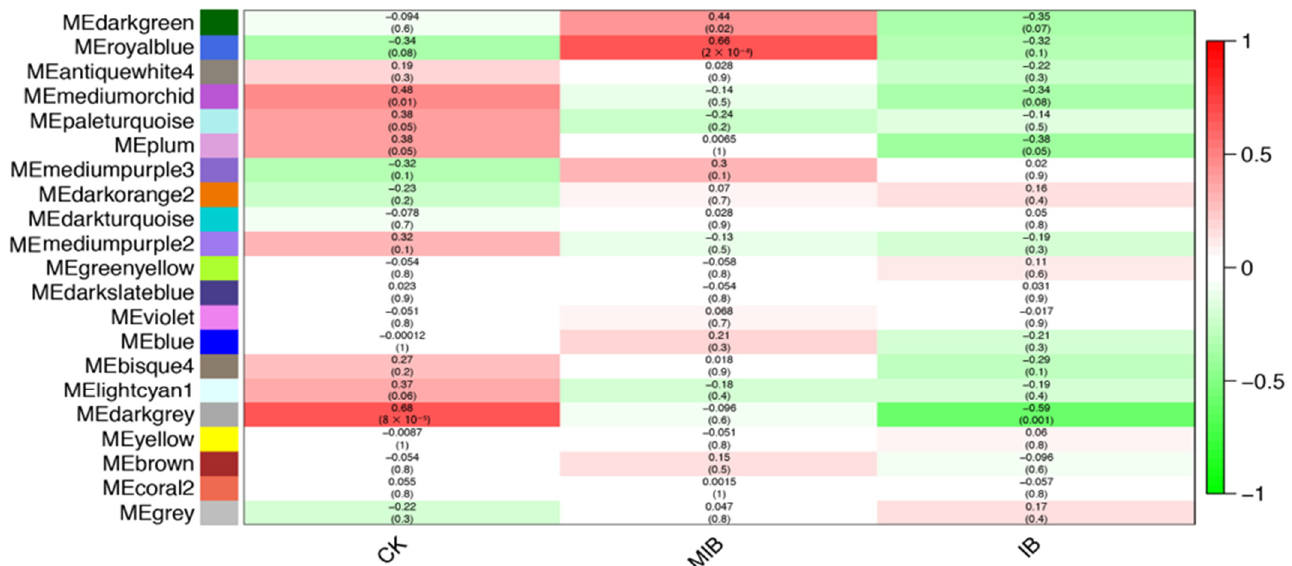
Figure 8. Correlation between identified co-expression modules and sample treatments. The x-axis includes three different treatments. CK indicates control samples without any treatment. MIB indicates artificially damaged samples without BPH infection. IB indicates rice samples with BPH infection. The y-axis shows different co-expression modules. The color indicates correlation values ranging from − 1 to 1. These values are also listed in the upper line of each module block. A higher value indicates a high correlation, and vice versa. In addition, p values are presented in each module block with parentheses citing them.